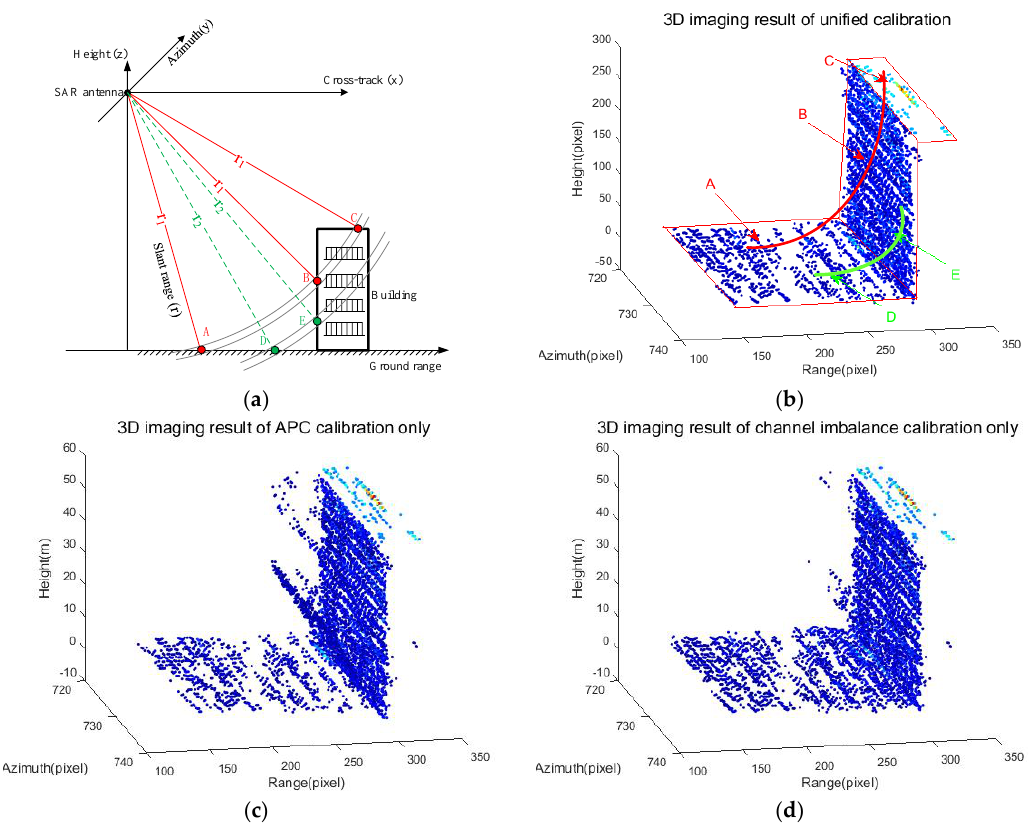
Figure 12. 3D imaging results of the layover building. ( a ) The building observation geometry. ( b – d ) 3D imaging results of the layover building utilizing the proposed unified calibration algorithm, APC calibration only, and channel imbalance calibration only, respectively.